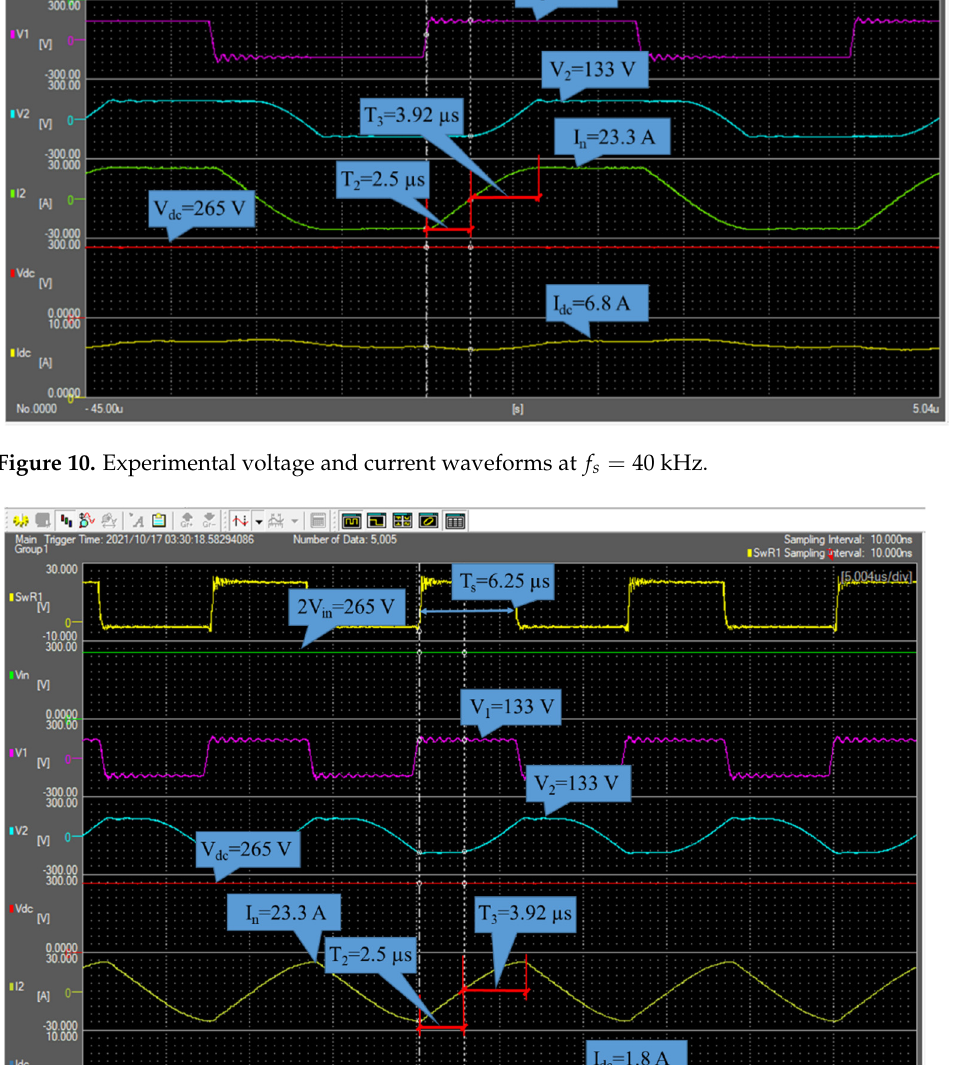
Figure 11. Experimental voltage and current waveforms at 𝑓 (cid:3046) = 80 kHz .